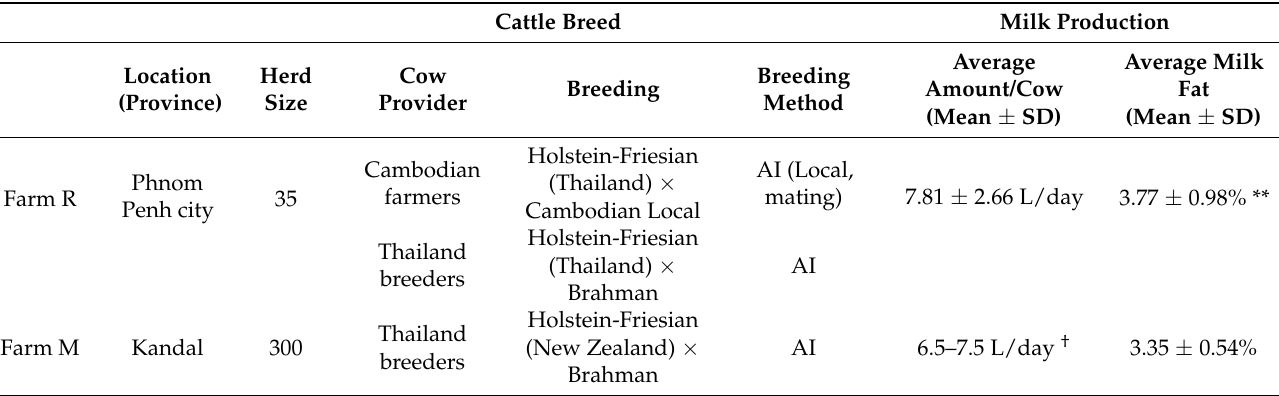
Table 1. Summary of the cattle breeds and milk production in two farms. Cattle Breed Milk